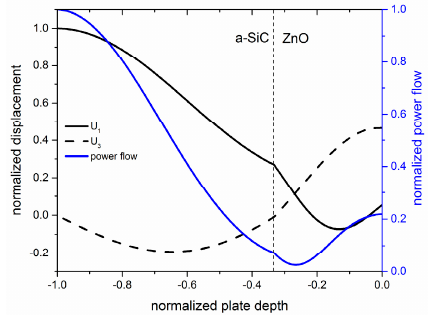
Figure 4. The field profile and in-plane power flow per unit area for the qL 1 mode propagating along a-SiC and ZnO thicknesses equal to 5 and 2.5 µm, for λ = 16.7 µm.